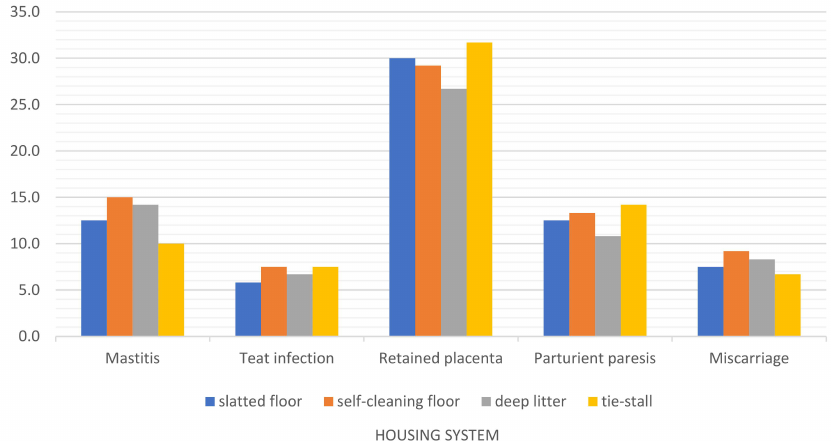
Figure 9. Prevalence of mammary gland and reproductive disorders in dairy cows kept in different housing systems in 2015–2020.